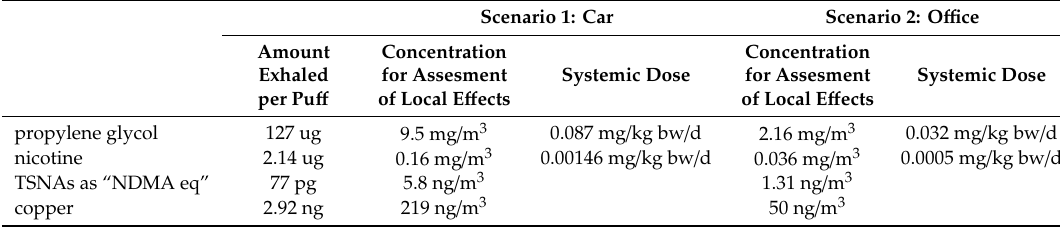
Table 5. Exposure concentrations and systemic